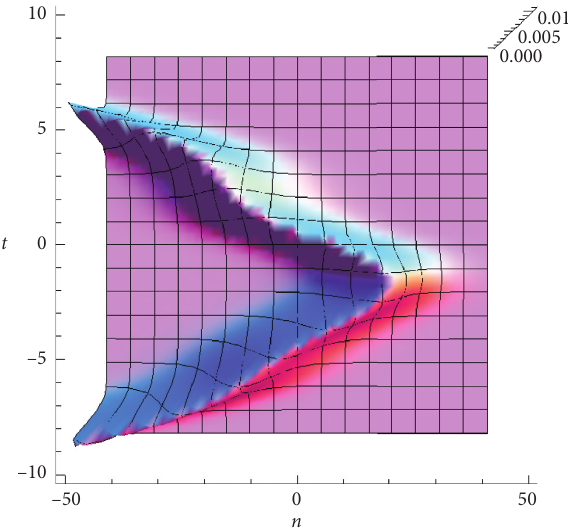
� 1, α � t , α � cos t , 0 1 2 � 0 . 1